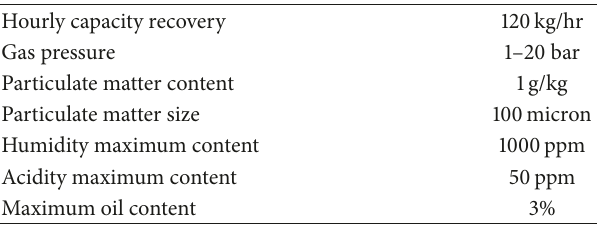
Table 1: Specifications for the design of the gas recovery